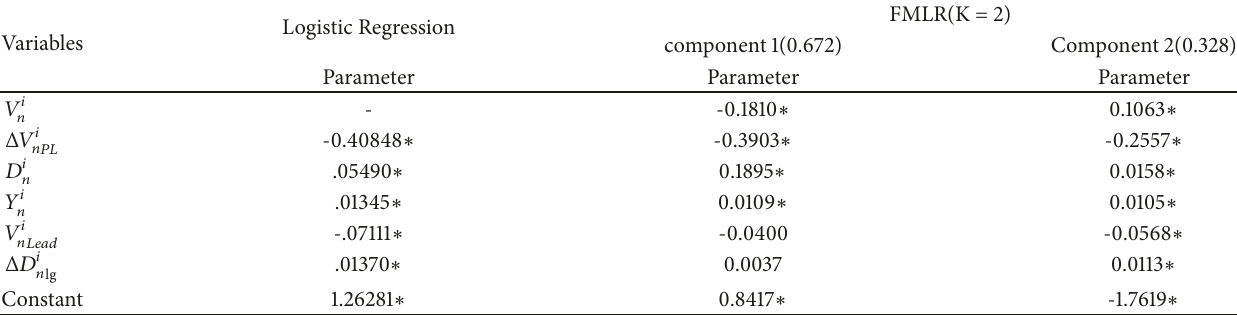
Table 5: Model estimation results of FMLR model.